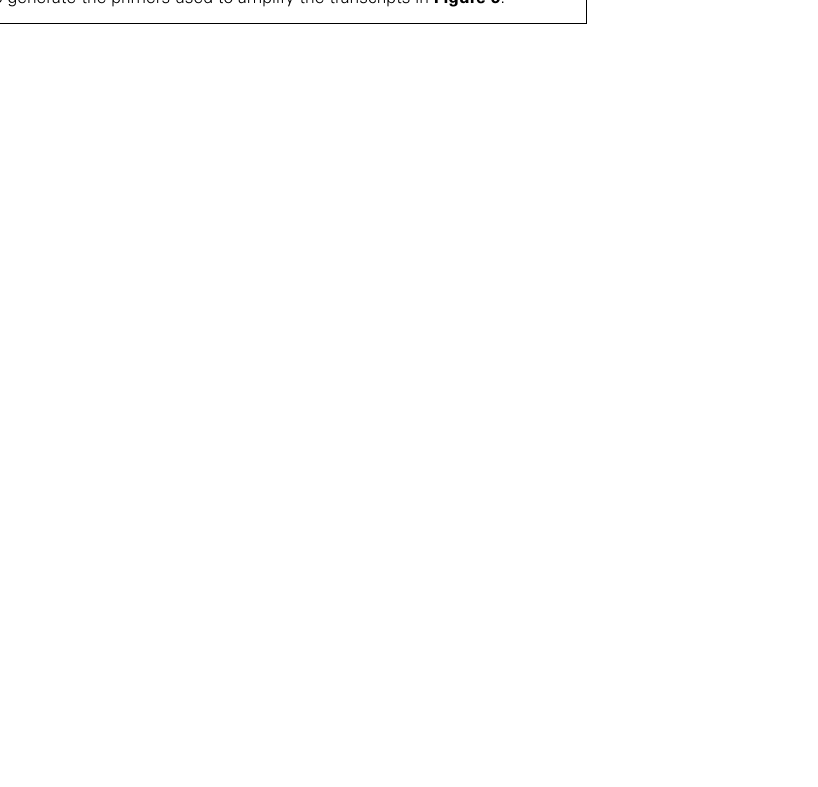
FIGUREA3 | Results of nested 3 (cid:2) RACE demonstrating the single BMS transcript in lane 2, and azadC transcripts labeledA–D (lanes 3–5). Lane 1 is a ddH 2 O negative control.These bands were cloned and sequenced to identify the polyadenylation sites present in theTCUP transcripts. Sequencing of these PCR products along with 5 (cid:2) RACE products were used to generate the primers used to amplify the transcripts in Figure 6